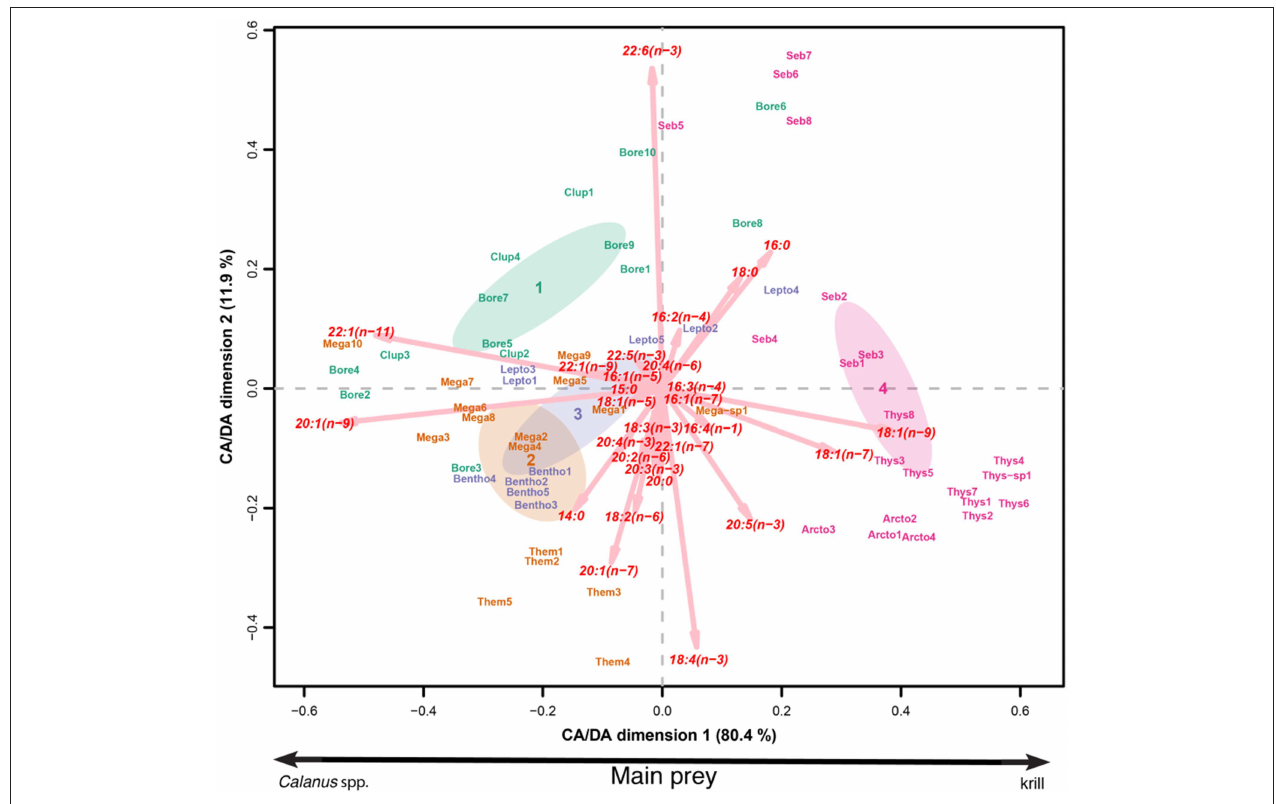
FIGURE 5 | Ordination plot of the CA/DA conducted on the concentration (%) of FATM for each individual organism. Bore corresponds to Boreogadus saida , Clup to Clupea harengus , Them to Themisto libellula , Mega to Meganyctiphanes norvegica , Lepto to Leptoclinus maculatus , Bentho to Benthosema glaciale , Seb to Sebastes mentella , Thys to Thysanoessa inermis , and Arcto to Arctozenus risso